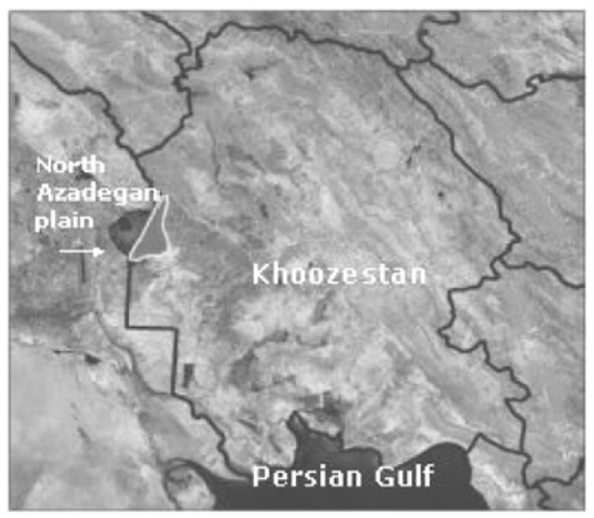
Fig. 9 North Azadegan Plain (Mirzaei 2010)